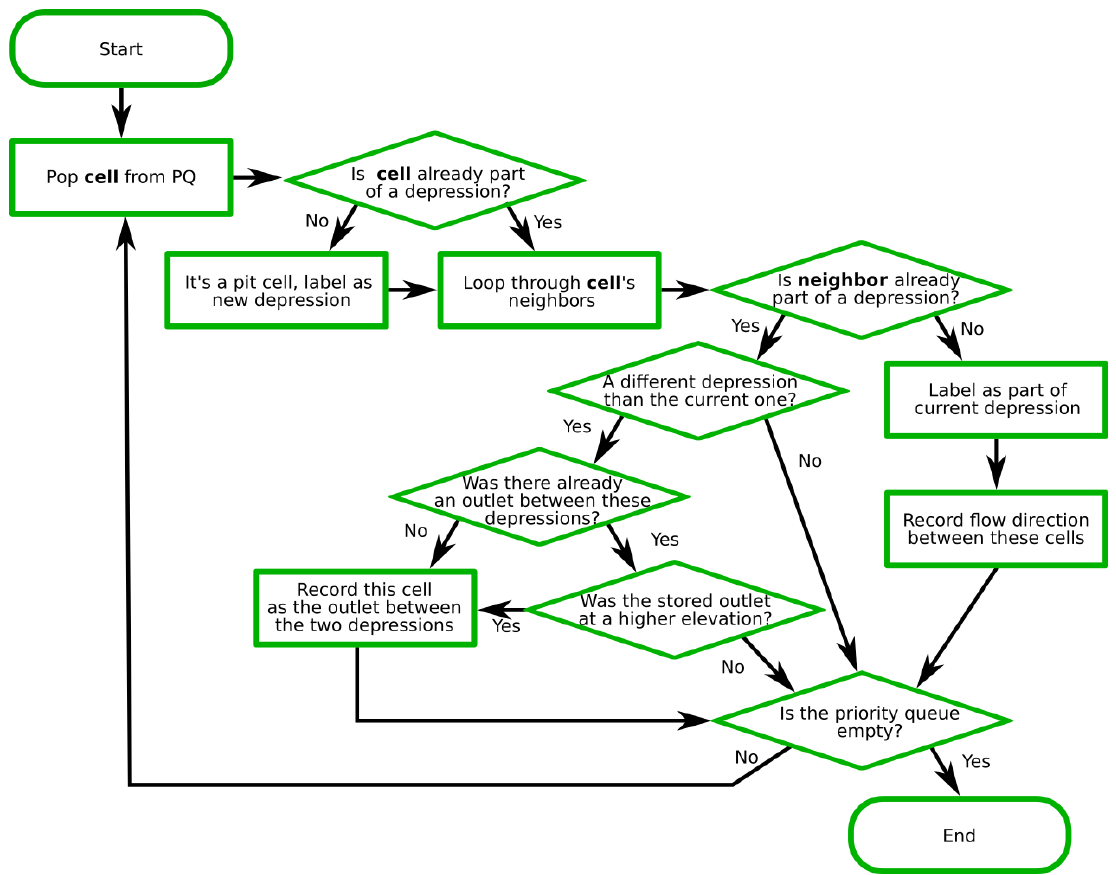
Figure 5. Cell assignment to unique depressions. Each cell receives a number that is its leaf label. See Fig. 4 for a description of how this process fits into the overall depression hierarchy